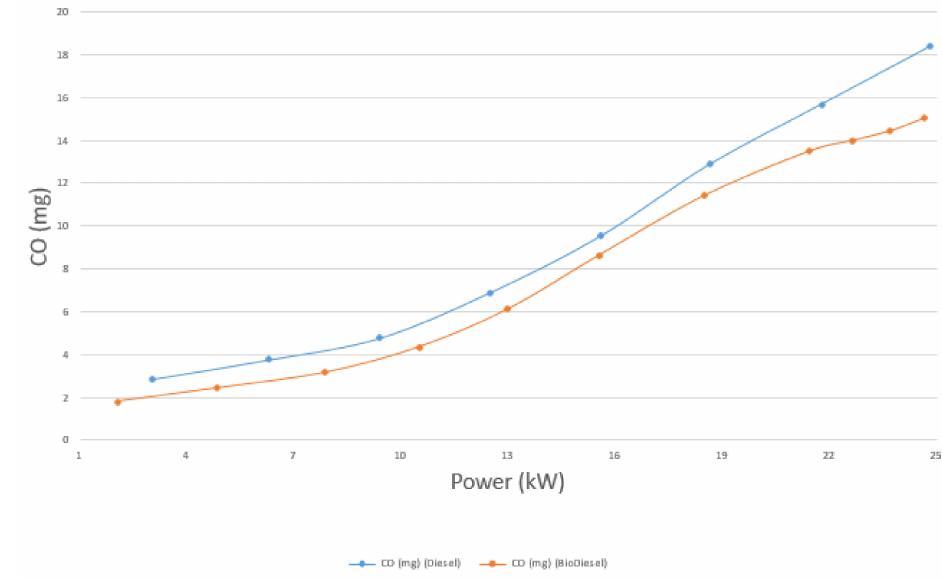
Figure 18. CO vs.